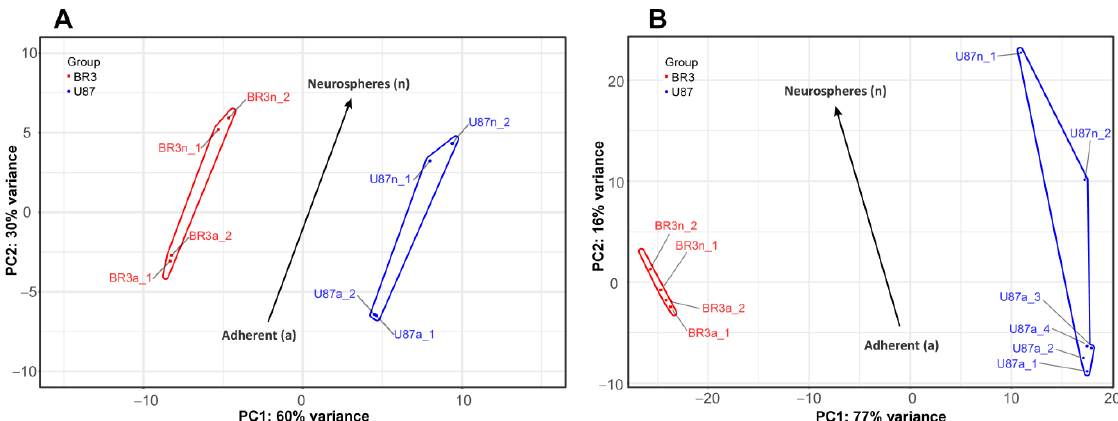
Figure 2. Principal component analysis (PCA) of DESeq2 normalized, variance stabilizing trans- formed (VST) gene expression data. PC1:PC2 graphs for small RNAs ( A ), and long RNAs ( B ) NGS-libraries. Cell culture specific PC1:PC2 points are annotated with colored envelopes. The black arrows show the general trends of PC1:PC2 transition from the MN (“a”, adherent) to the NS state (“n”, neurospheres).